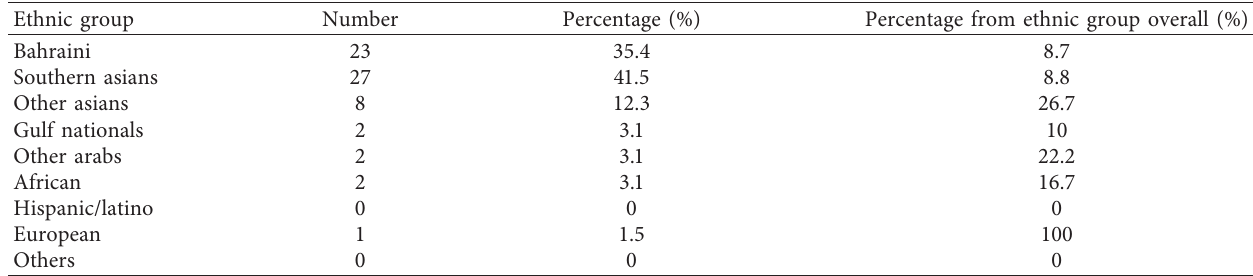
Figure 1: Correlation between monthly incidence and mean recorded temperature. Table 4: Complicated cases by ethnic group.